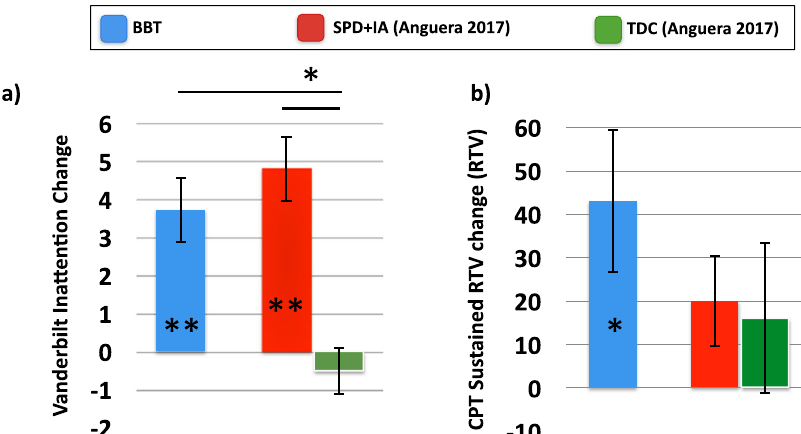
Fig. 5 Comparison of primary outcomes to Anguera et al. (2017). a Change on Vanderbilt Inattention Measure for BBT cohort and participants from Anguera et al. (2017). b Change on CPT task on the Sustained Condition for BBT cohort and participants from Anguera et al. (2017). SPD + IA = Children with Sensory Processing Disorder and ADHD comorbidity. TDC Typically Developing Children. Error bars represent s.e.m. * p < 0.05, ** p < 0.01.